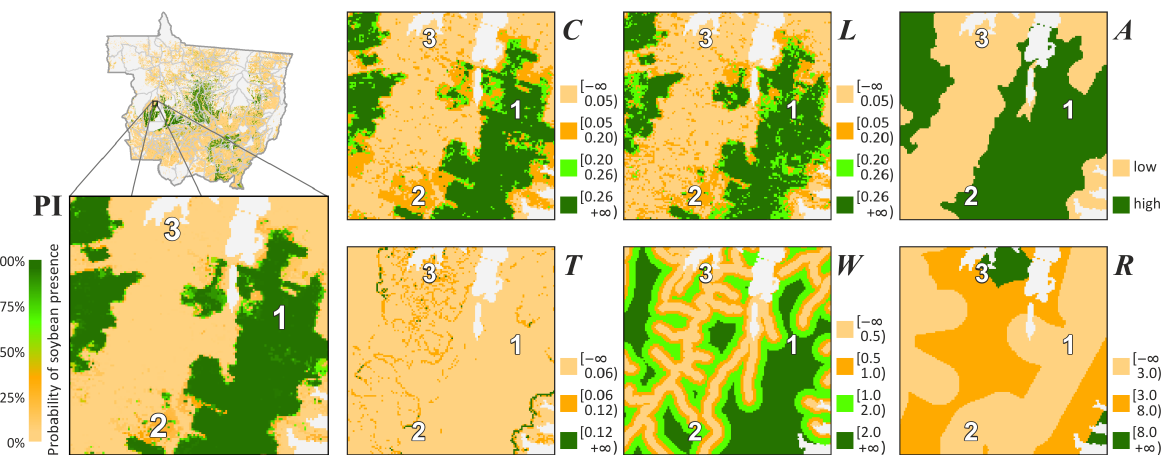
Figure 10. Probability Image (PI) of soybean presence and six context variables (described in Table 1) zoomed in on the central part of the Sapezal municipality. The legend for the context variables followed the intervals stated in Table 2. Regions labeled 1, 2, and 3 show respectively, ideal, intermediate and poor conditions for soybean